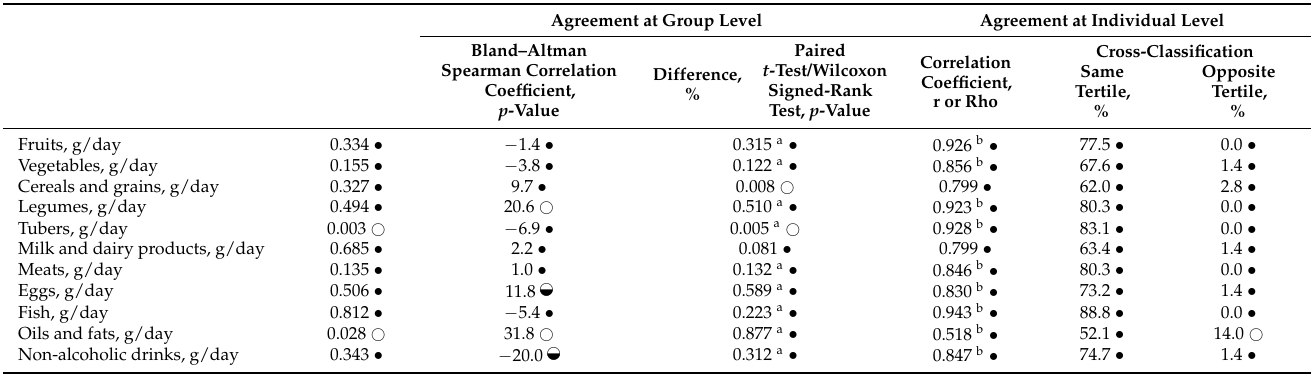
Table 2. Summary of statistical test outcomes and interpretation of food group intakes to assess the relative validity of Remind